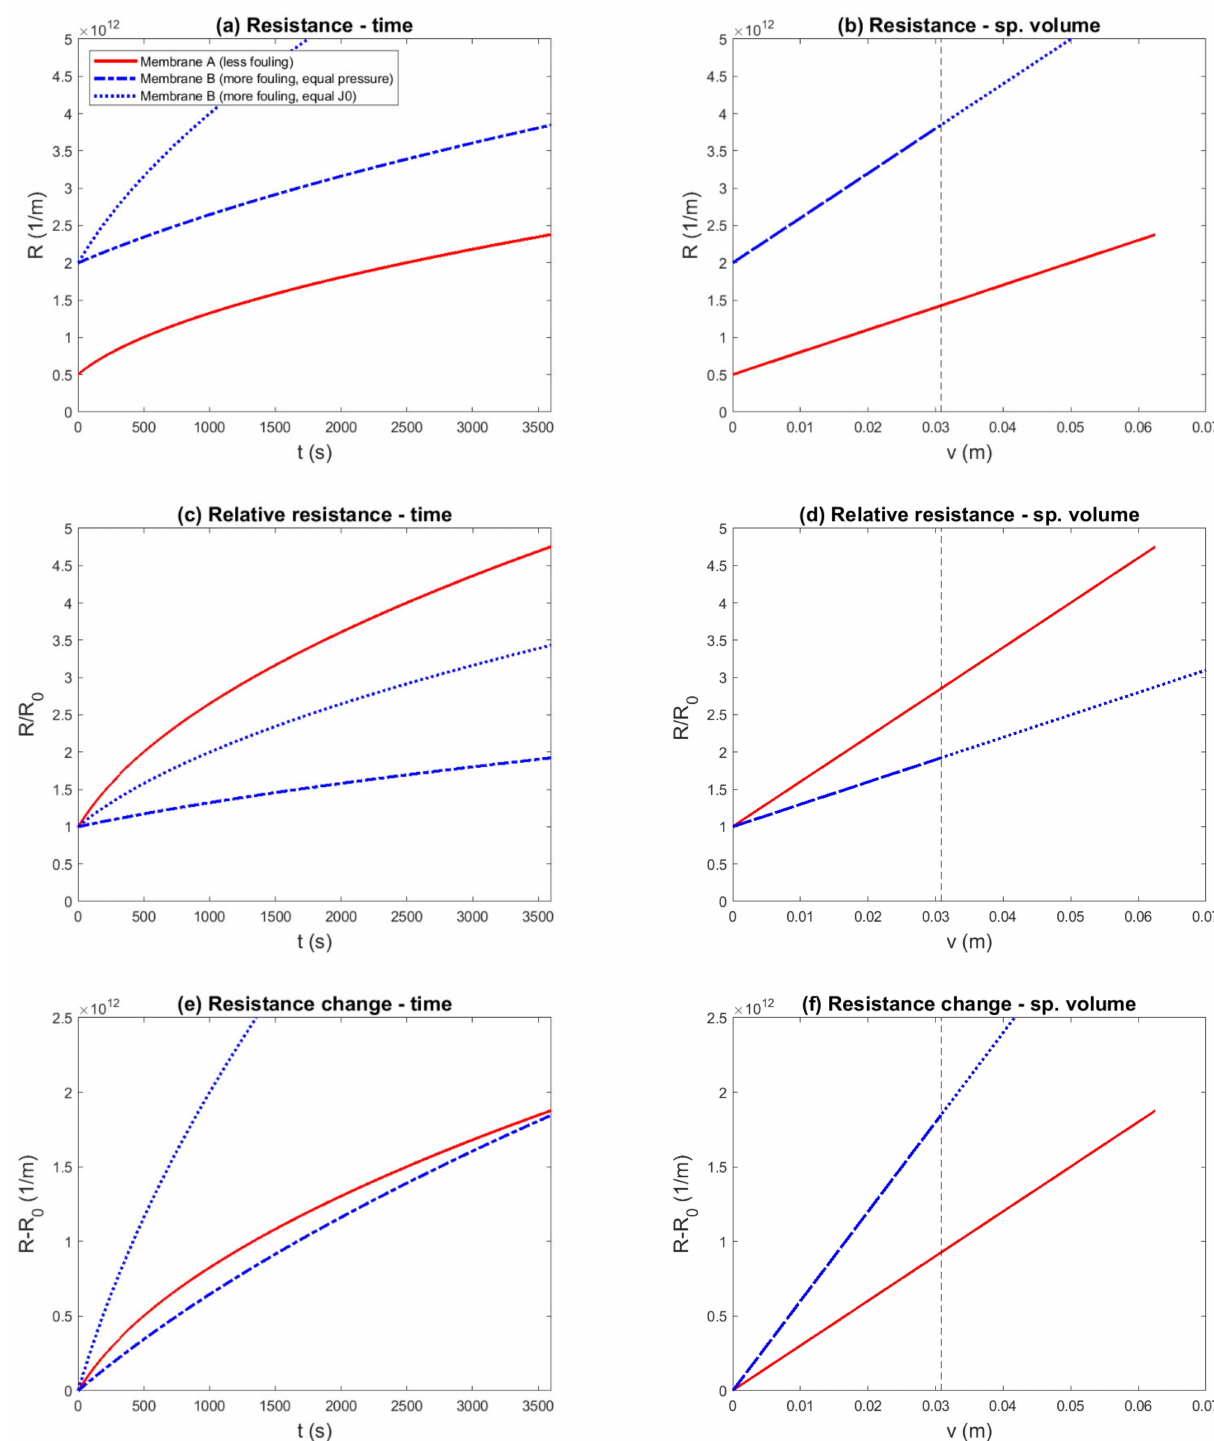
Figure 2. Simulated constant-pressure experiment, aiming to compare two membranes with equal transmembrane pressure (0.25 bar) and equal initial flux (TMP B = 1 bar), and several pressure- and resistance-based data representations. The example was constructed such that membrane A was superior to membrane B, due to both a lower membrane resistance ( R MA = 0.5 × 10 12 m − 1 vs. R MB = 2.0 × 10 12 m − 1 ) and a lower fouling rate ( α A = 3.0 × 10 13 m − 2 vs. α B = 6.0 × 10 13 m − 2 ). Different representations ( a —Resistance–Time; b —Resistance –Specific Volume; c —Relative Resistance–Time; d —Relative Resistance–Specific Volume; e —Resistance Change–Time; f —Resistance Change–Specific Volume) were compared to evaluate if the known difference in fouling propensity was correctly reflected: ( c – e ) suggest a conclusion contradicting the underlying